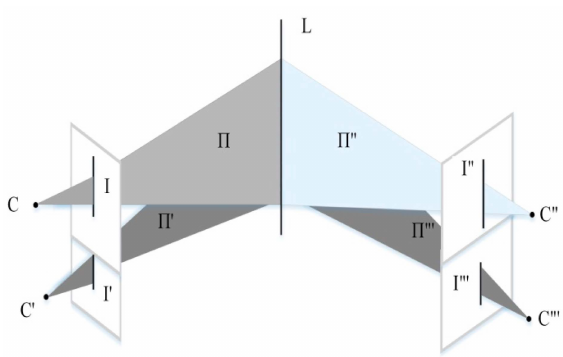
Figure 6. The Quadrifocal Tensor